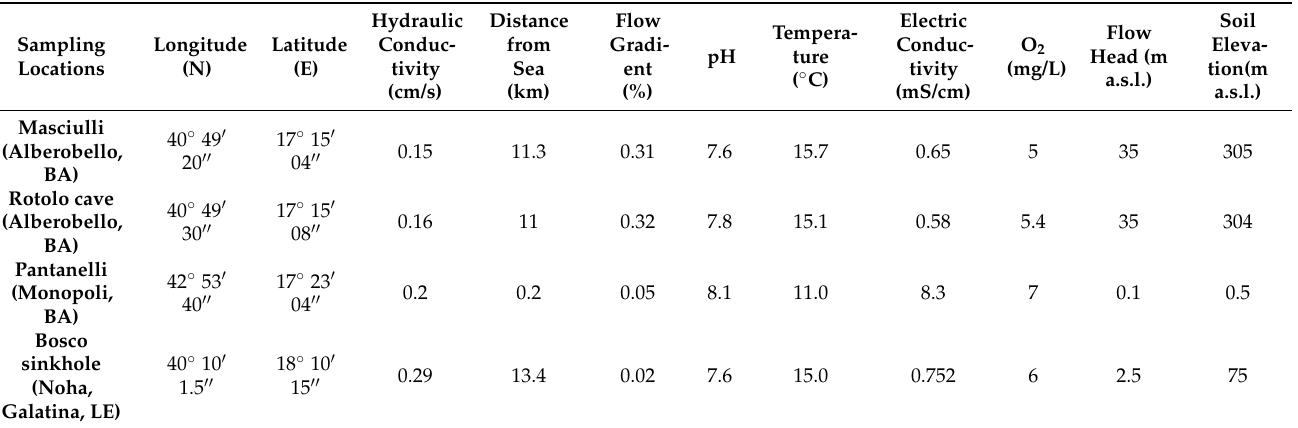
Table 1. Sampling sites of regional stygofauna in Puglia, Southern Italy and monitored environmental conditions (average